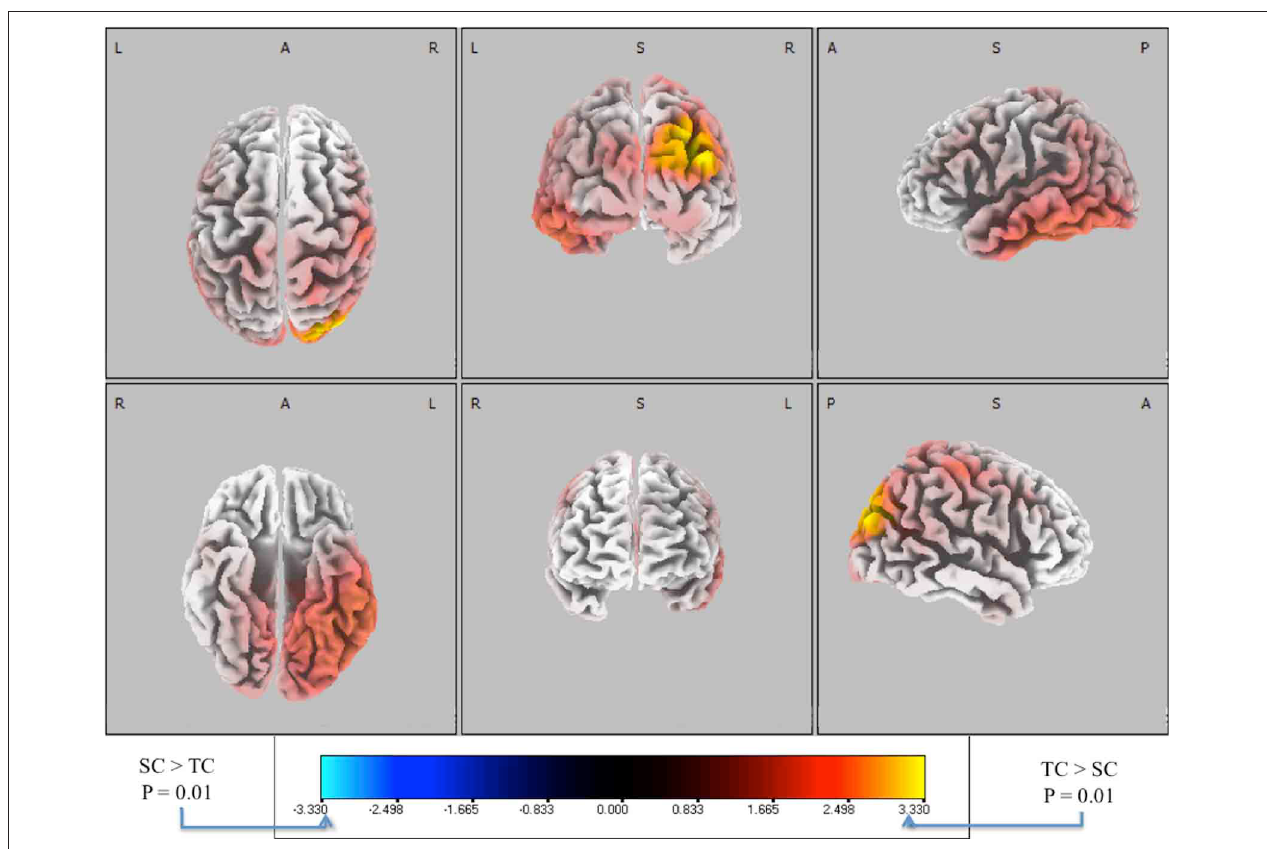
FIGURE 7 | Six-views of neuronal current paired t -tests (side response-correct (standard correct or SC) in purple/blue, front response-correct (target correct or TC) in orange/yellow) across all discriminating subjects. In both plots, the t-distribution of the log of the F -ratio for each voxel is shown [ F ( 1 , 20 ) ] with brighter colors indicating higher values of the t -statistic according to the color scale. Significance was established with a permutation test (2000